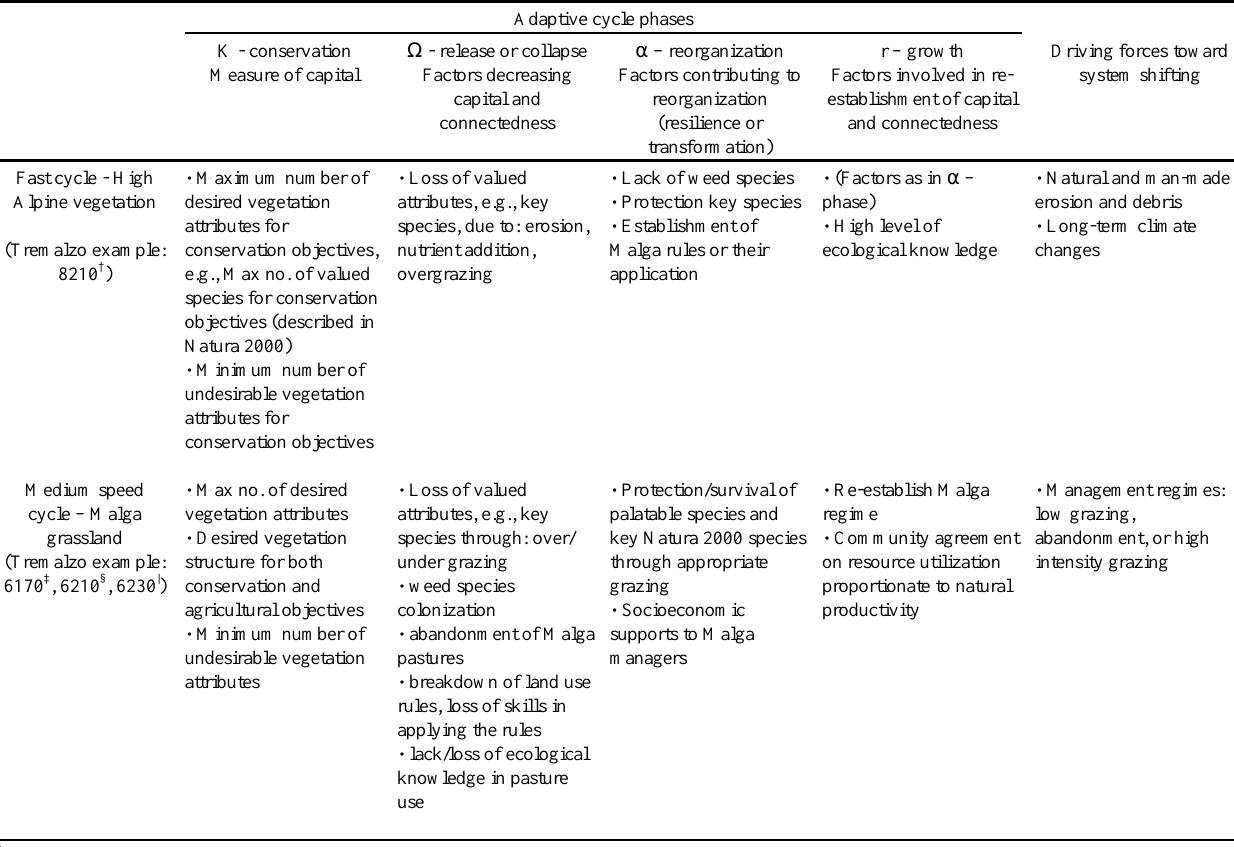
Table 1 . Adaptive cycles in vegetation types (recognized within Natura 2000) of the Tremalzo case study.